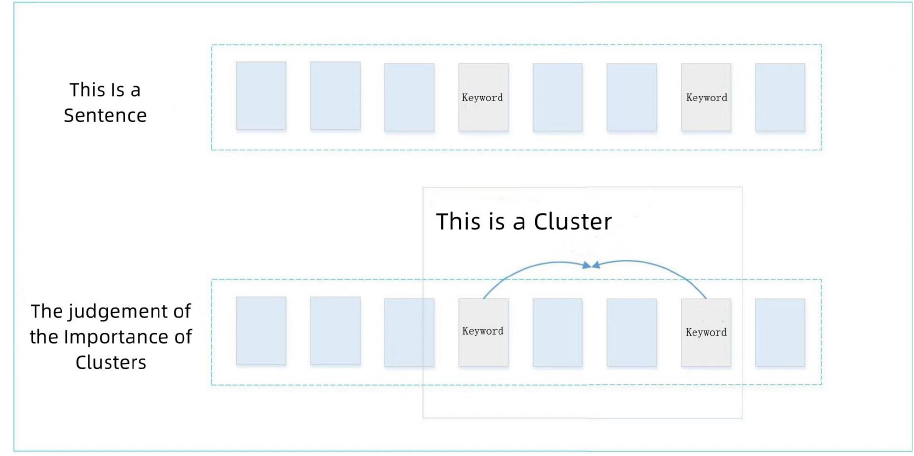
Figure 4. Key sentence extraction based on cluster.